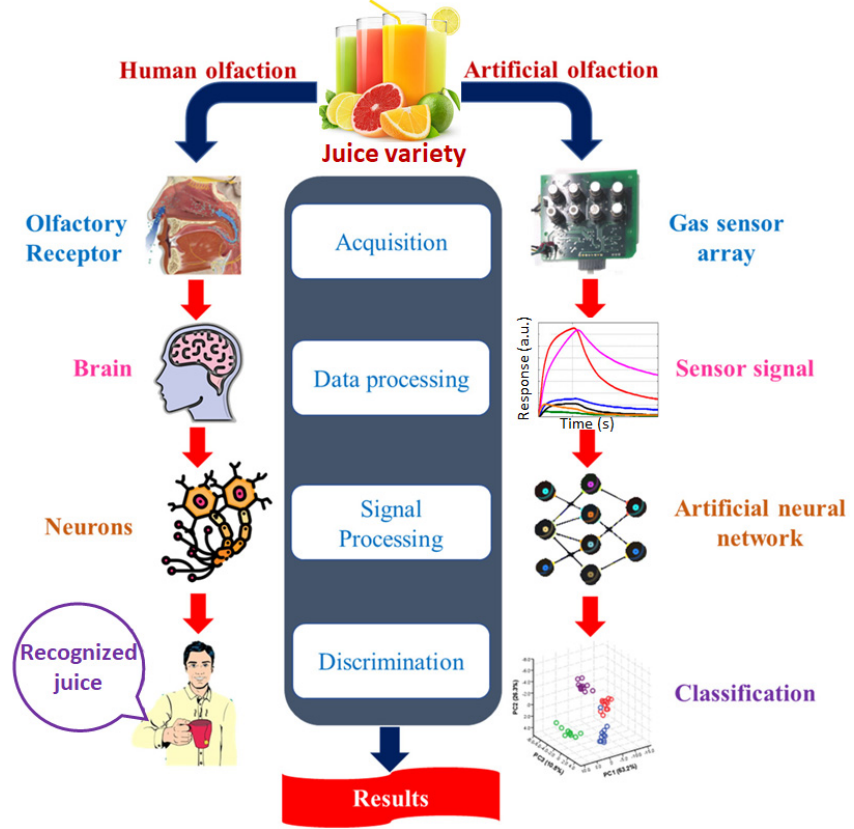
Figure 6. Schematic representation of an e ‐ nose device and comparison of biological olfaction by the human nose and artificial olfaction by the e ‐ nose. Adapted from ref. [89].